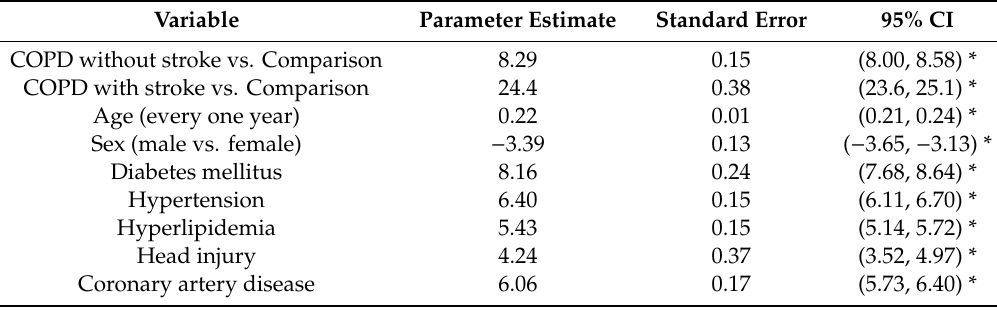
Table 5. Stepwise regression analysis of the frequency of medical visits per year.